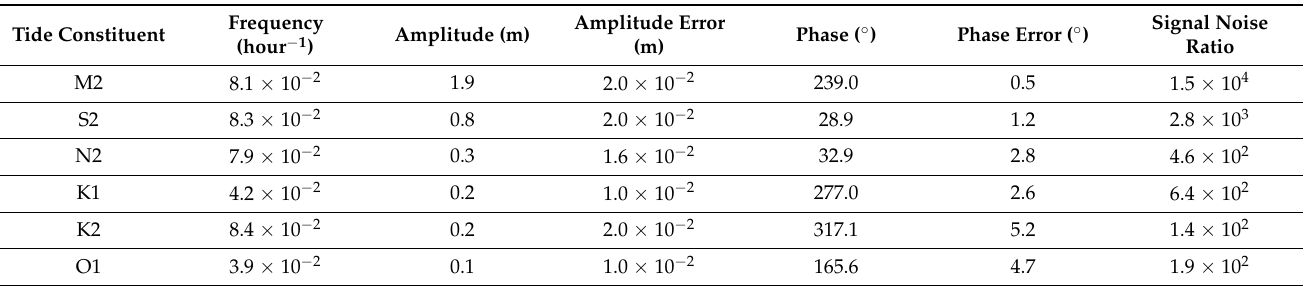
Table 2. Characteristics of the six tide constituents by harmonic analysis with a signal-noise ra- tio greater than 100. M2, S2, N2 and K2 are semidiurnal tidal components, while K1 and O1 are diurnal